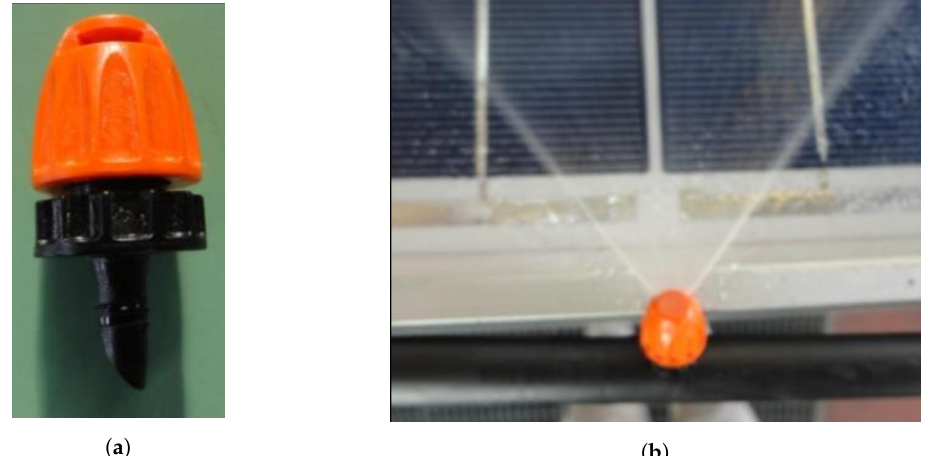
Figure 8. ( a ) Nozzle used to spray the water, ( b ) 90 ◦ nozzle spraying angle. By courtesy of [68].